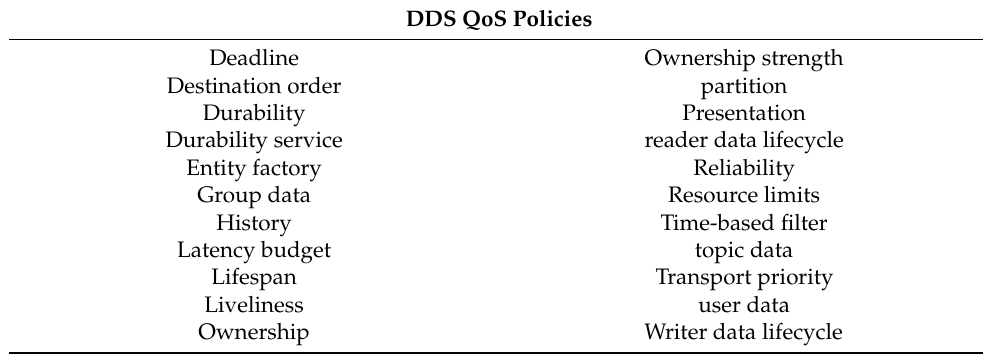
Table 1. Data distribution service (DDS) quality of service (QoS)